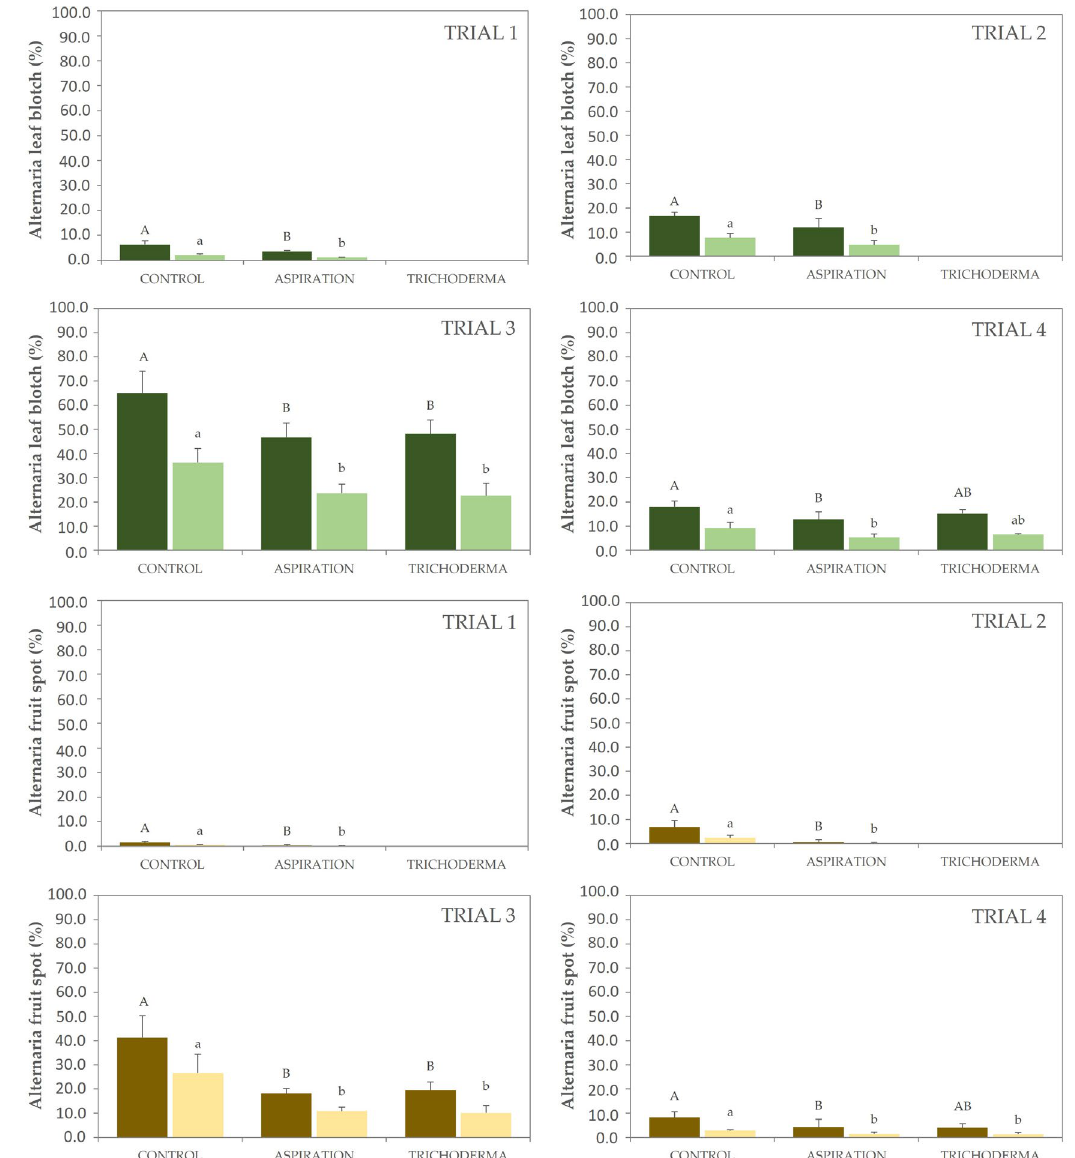
Figure 3. Incidence (dark plots) and severity (clear plots) of Alternaria leaf blotch (green series) and fruit spot (brown series) in commercial orchards where fallen leaves were collected by aspiration during winter or treated with T. asperellum during spring in comparison with controls without any inoculum management. Data correspond to the evaluations of 5 August 2019 for trial 1, 9 August 2019 for trial 2, 27 July 2020 for trial 3, and 29 July 2021 for trial 4. Data are presented as the mean of four replicates with the standard deviations (vertical bars). Different letters (capital letters for incidence and lowercase letters for severity) show significant differences between the treatments according to Student’s t test ( p < 0.05) in trials 1 and 2, or Tukey’s test ( p < 0.05, ANOVA, LSD) in trials 3 and 4.